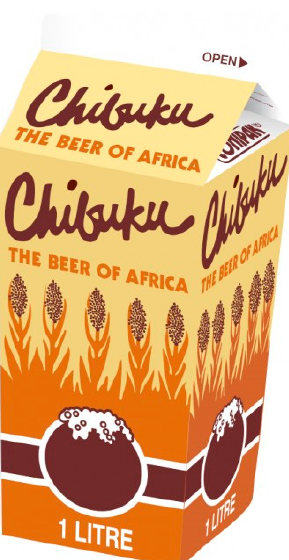
Figure 3. Brewing process of umqombothi .